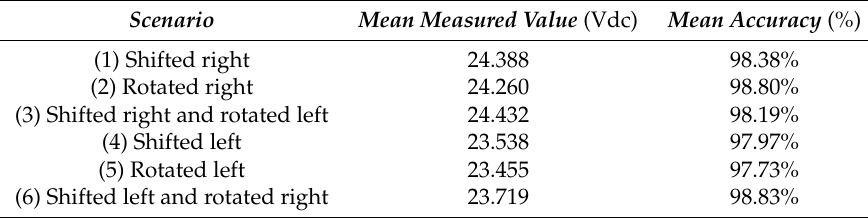
Table 11. Statistical results of the measured DC voltages plotted in Figure